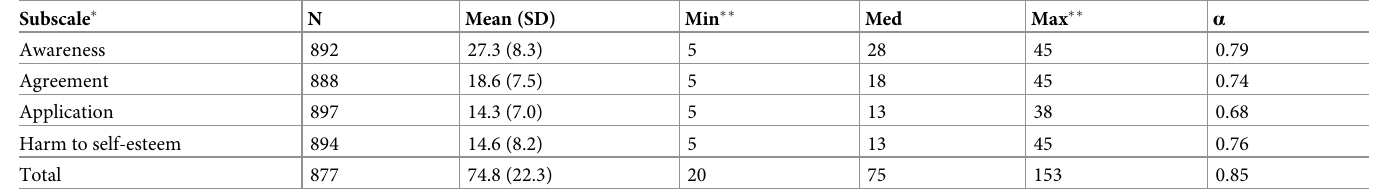
Table 2. Mean (SD), minimum, median scores, maximum and Cronbach’s alpha for each subscale in self-stigma for people with mental disorders using the SSMIS-SF. Subscale